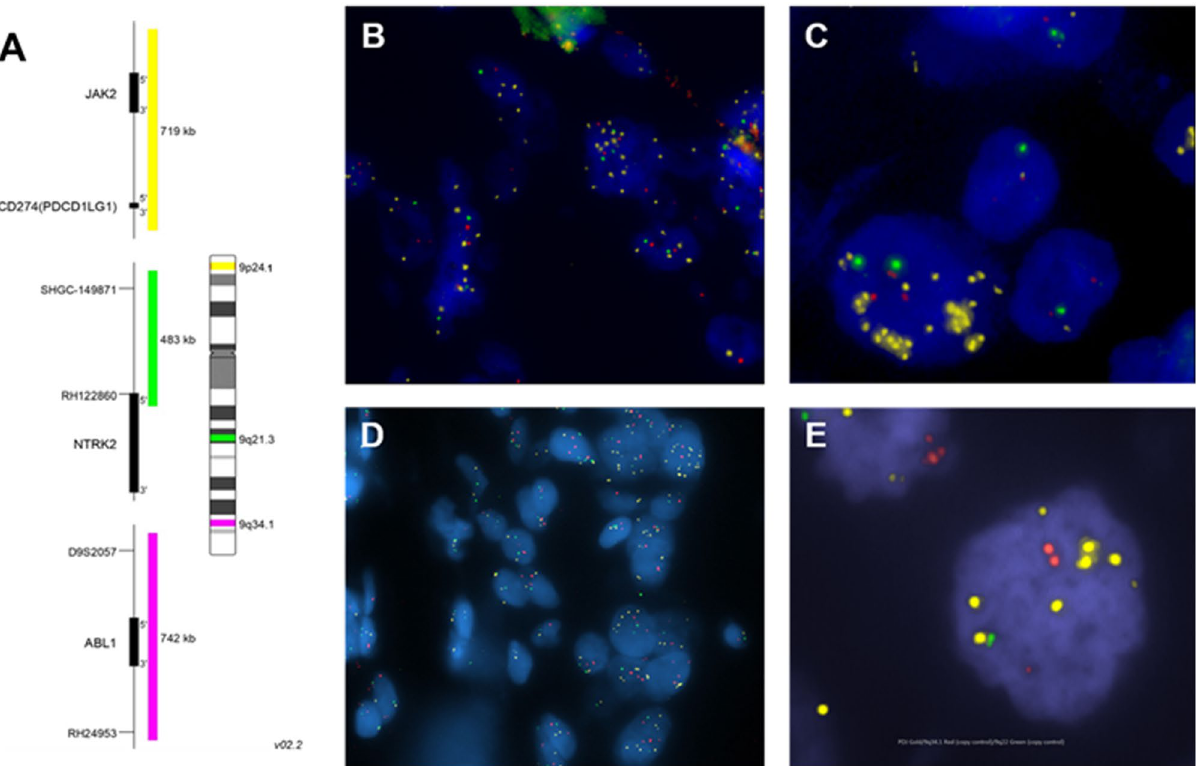
Figure 1. PDJ FISH analysis of TNBC samples. ( A ) Three color FISH assay includes probes for 9p24.1 JAK2/ PD-L1 (yellow), 9q21.3 NTRK (green) and 9q34.1 ABL1 (red) that discriminate PDJ amplicons from whole chromosome 9 gains. ( B , C ) Mayo Clinic Breast Cancer SPORE TMA1A samples 007 and 094. ( D ) Mayo Clinic Arizona (MCA) resected case MCA PS15.9602. ( E ) Howard University TMA sample DM-2651-A7 from a 30-year-old African American patient . PDJ + cases were identified based on our scoring criteria similar to those used for HER2 FISH that include mean copy number of > 4.5 and PDJ/reference ratio ≥ 2.0. In all cases 50 cells were scored to determine the PDJ